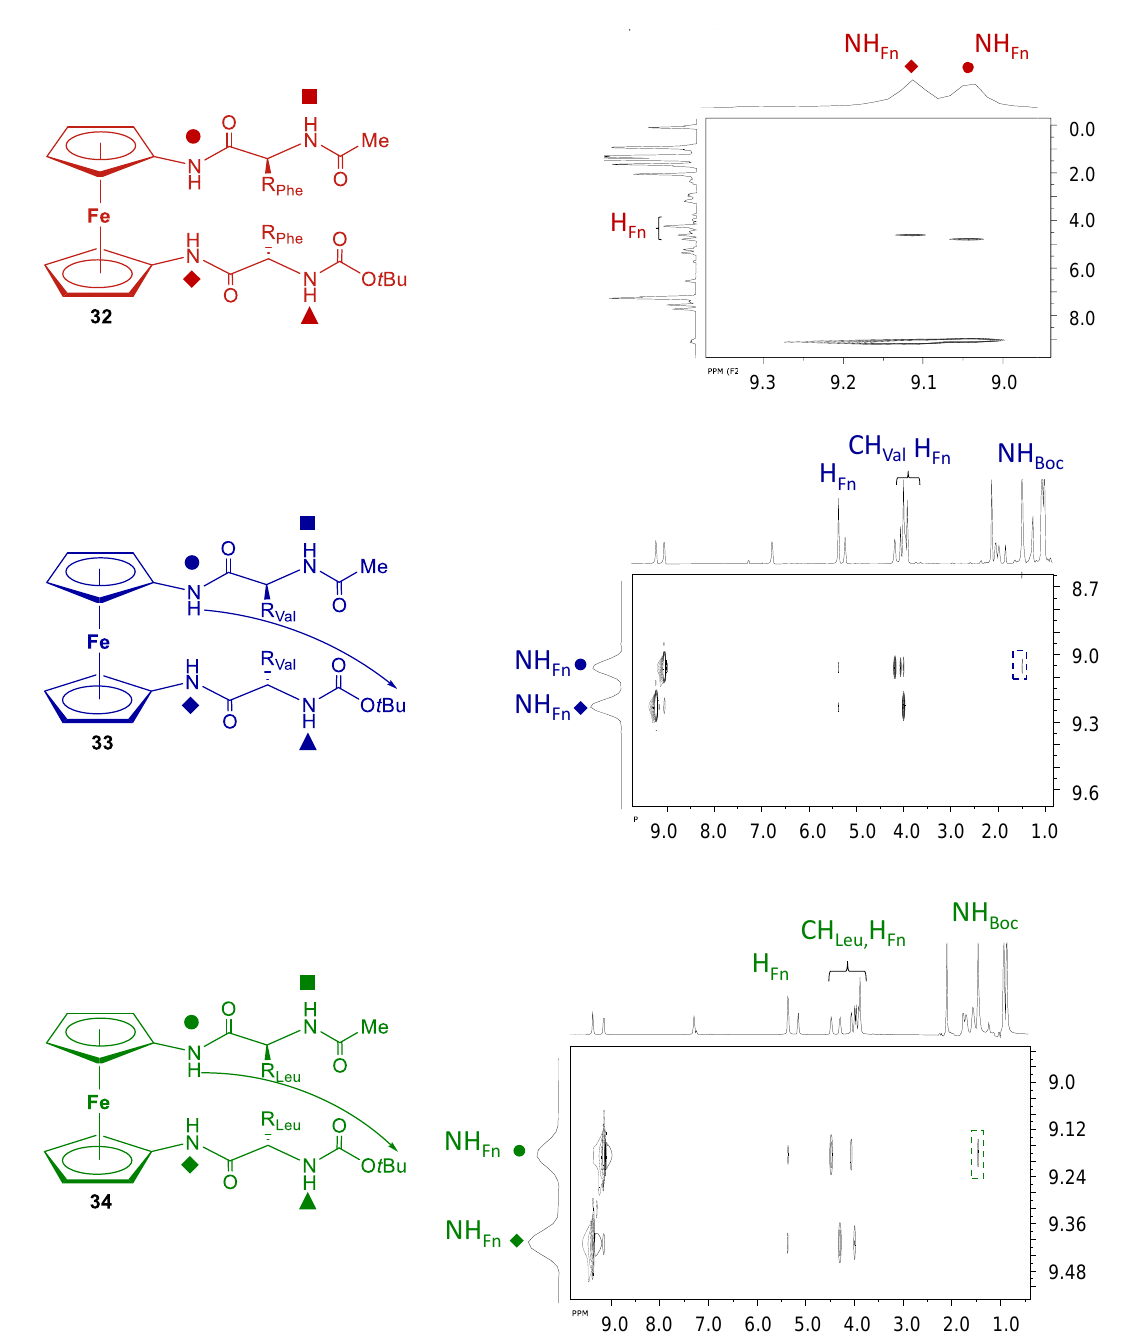
Figure 7. The interstrand NOE contacts in the spectra of conjugates 33 and 34 are depicted with arrows. The NOE contacts attributed to interstrand HBs are not observed in spectrum of conjugate 32 .